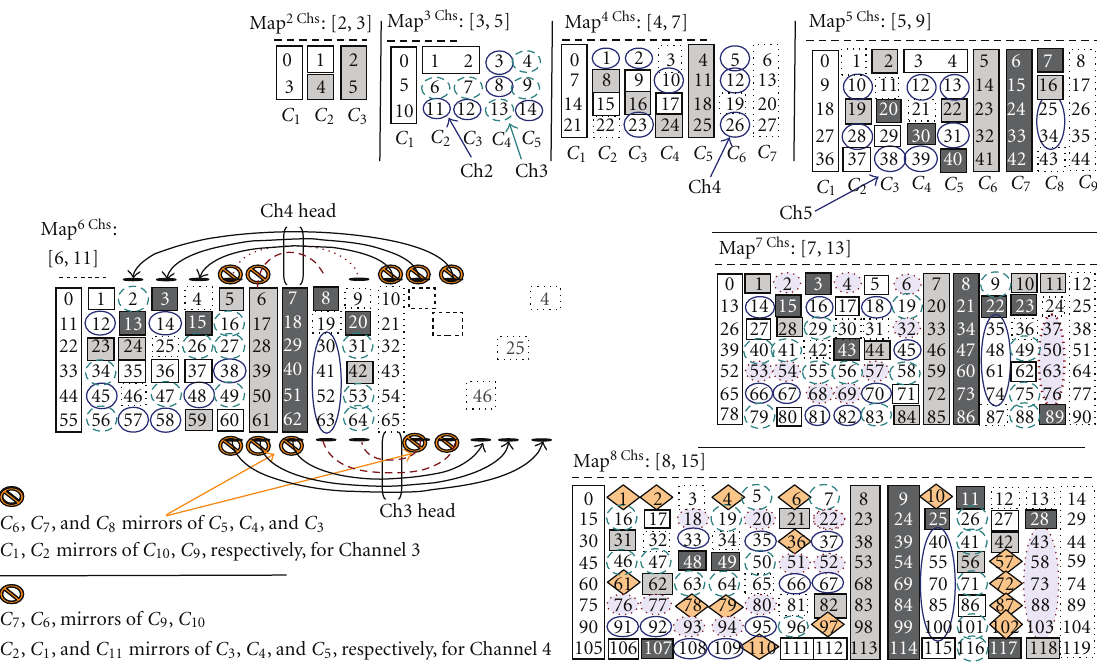
Figure 10: MtQS-DSrdv construction exemplary maps (Map r Chs) for r = 2 ··· 8.